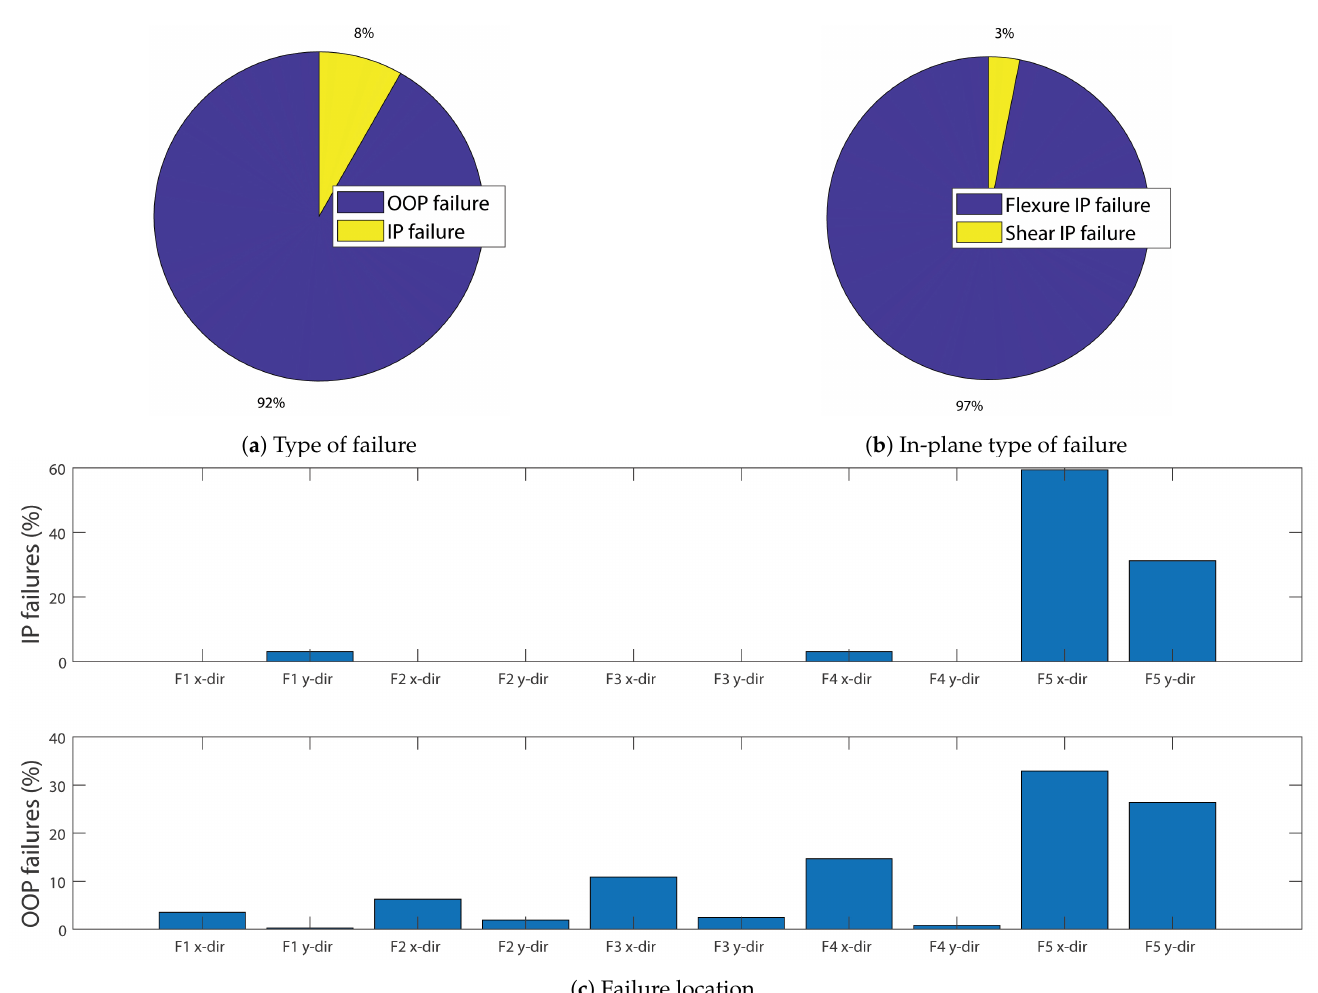
Figure 19. Lausanne Malley model failure statistics: ( a ) Type of failure. ( b ) In-plane type of failure. ( c ) Failure